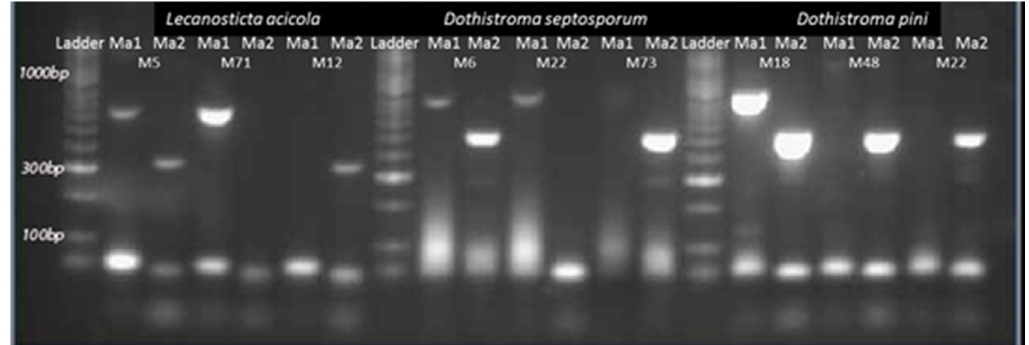
Figure 2. PCR amplicons of L. acicola , D. septosporum , and D. pini obtained using the MAT primers in PCR. The numbers at the top of the gel refer to sample number; Ma 1 Ma 2 refer to mating type MAT 1 and MAT 2, respectively; M5, M71, M12, M6, M22, M73, M18, M48, and M22 refer to sample numbers.